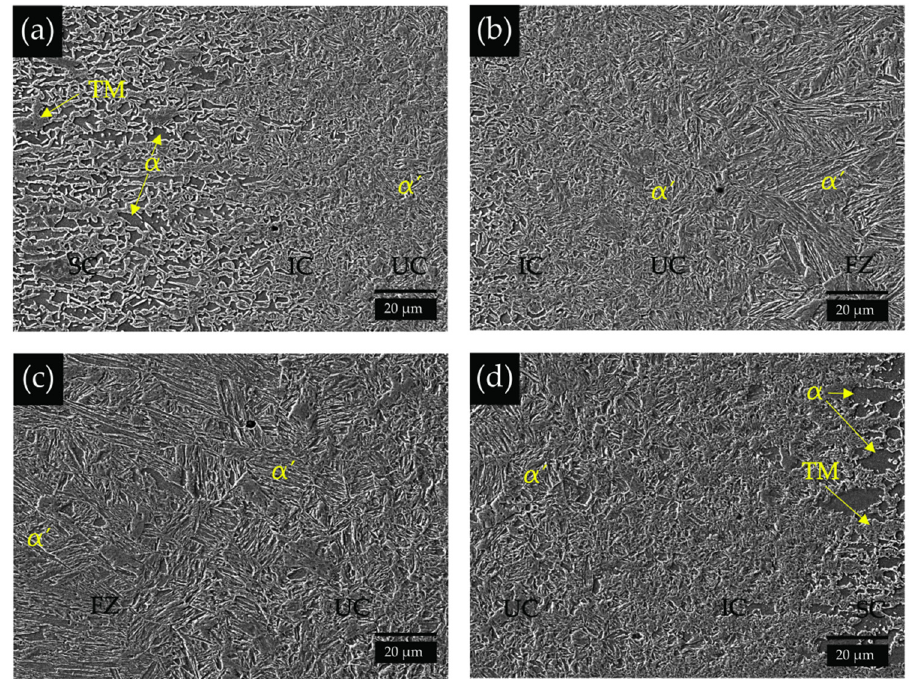
Figure 8. Microstructure development along the HAZ of the dissimilar TRIP-DP LBW specimen: macrographs taken from the TRIP steel side covering ( a ) SC, IC, and UC, ( b ) IC, UC, and partial view of the FZ. Macrographs taken from the DP side covering ( c ) partial view of FZ and UC-HAZ, ( d ) UC, IC, and SC HAZ.